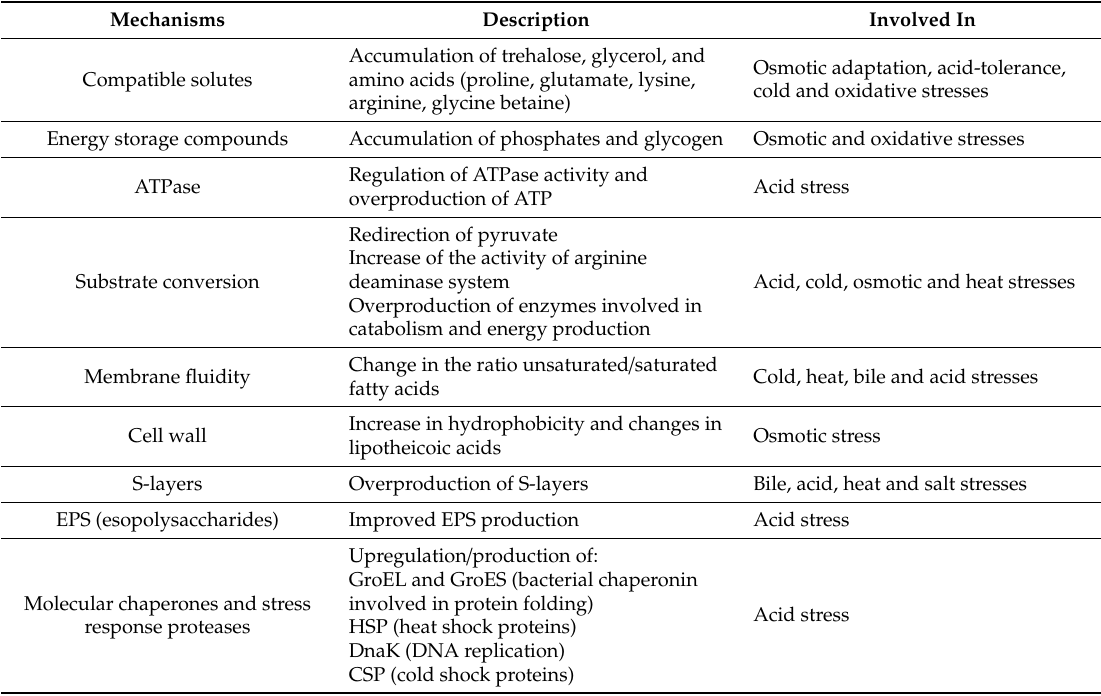
Table 2. Stress adaptation triggered by pretreatments (references and data reported in Gaucher et al.